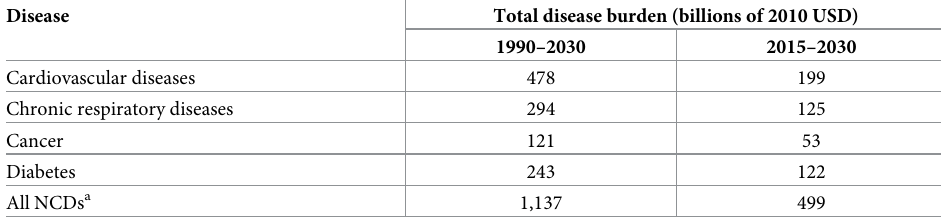
Table 1. Estimates of lost GDP due to the four leading NCDs and due to all NCDs associated with air pollution in China (in billions of 2010 USD).